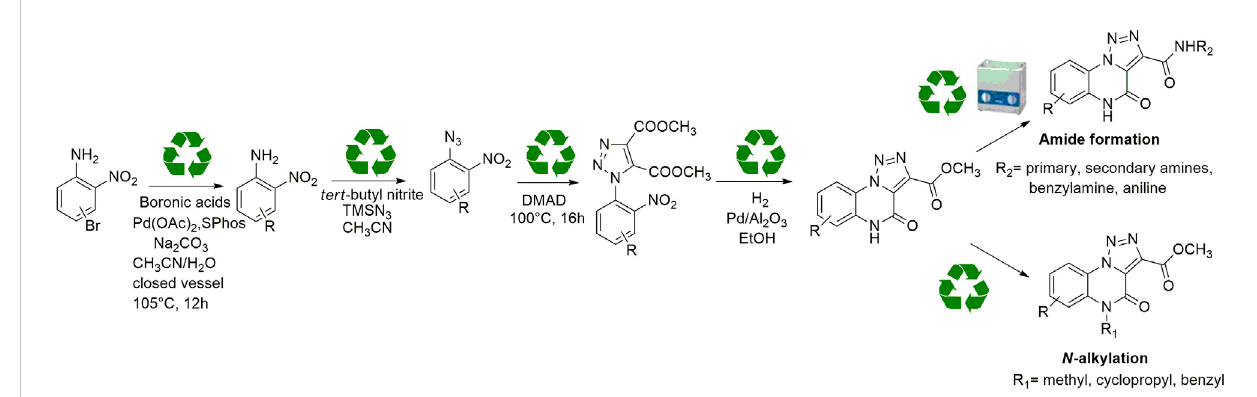
SCHEME 3 General scheme for the newly conceived sustainable approach for the synthesis and derivatization of [1,2,3]-triazolo [1,5-a] quinoxalin-4(5 H )-ones.